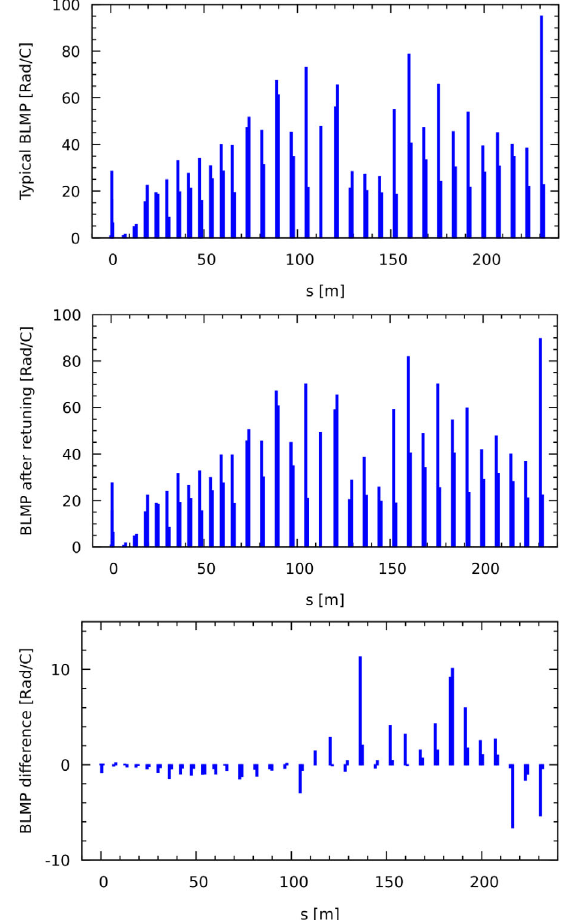
FIG. 14. Beam loss monitor patterns (BLMPs) during regular operation (top) and after retuning with the SRF cavity off (middle). The bottom graph shows the difference of the two